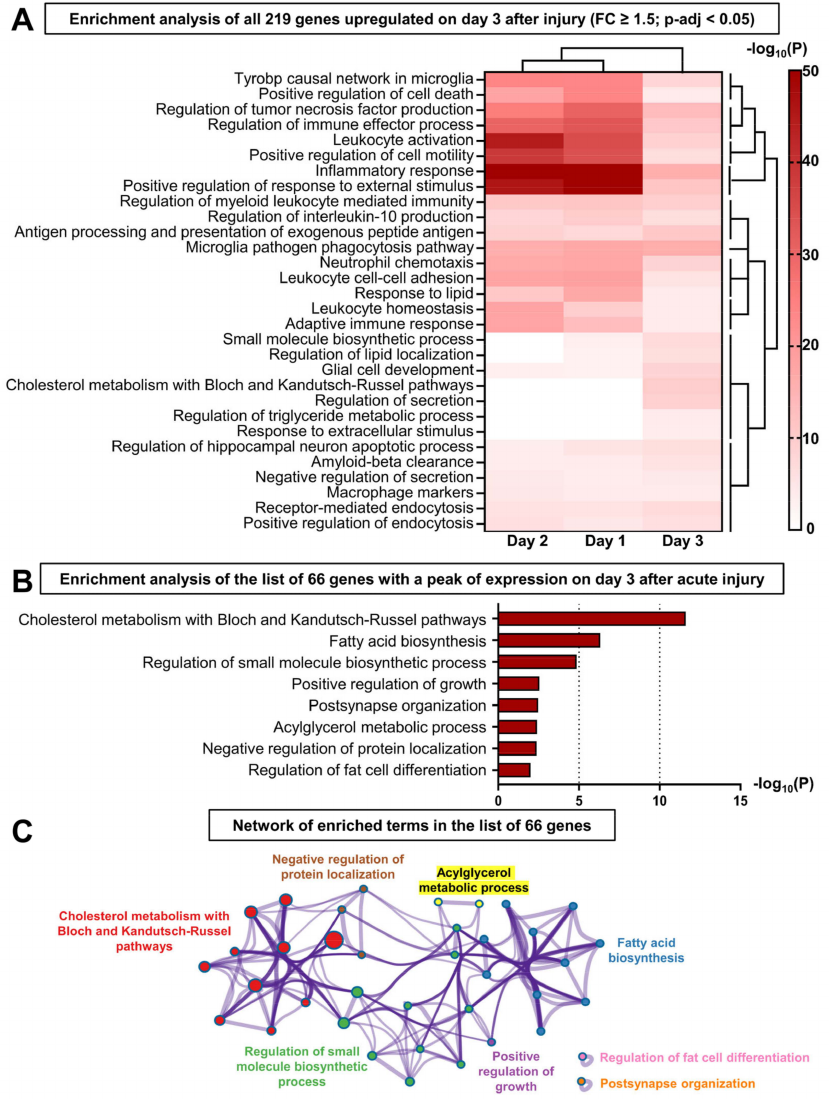
Figure 5. Activation of lipid biosynthesis is specifically activated at the switch to repair after LG injury. ( A ) Top 30 enriched pathways obtained by analyzing the list of 219 genes upregulated (relative to uninjected control, FC > 1.5, p -adj < 0.05) on day 3 after IL1- α -injury using Metascape. Enrichment p -values found on days 1 and 2 were added and a dendrogram was created with Clustergrammer to identify specific enrichment patterns. ( B ) Pathway enrichment analysis of the list of 66 genes supposedly promoting the resolution of inflammation using Metascape. ( C ) Network of enriched ontology terms obtained from the list of the 66 upregulated genes. One term from each cluster is selected to have its term description shown as cluster identity. Nodes that share the same cluster identity are typically close to each other and have the same color (i.e., nodes of the same color belong to the same cluster). The node size reflects the number of input genes that fall under that term. The thickness of the edge represents the similarity score